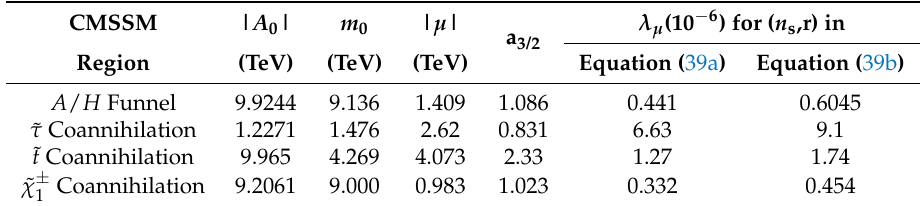
Table 4. The required λ µ values which render our models compatible with the best-fit points in the CMSSM, as found in Reference [101], for m 0 = m 3/2 , ) given in Equations (39a) and (39b). and ( n , r ±